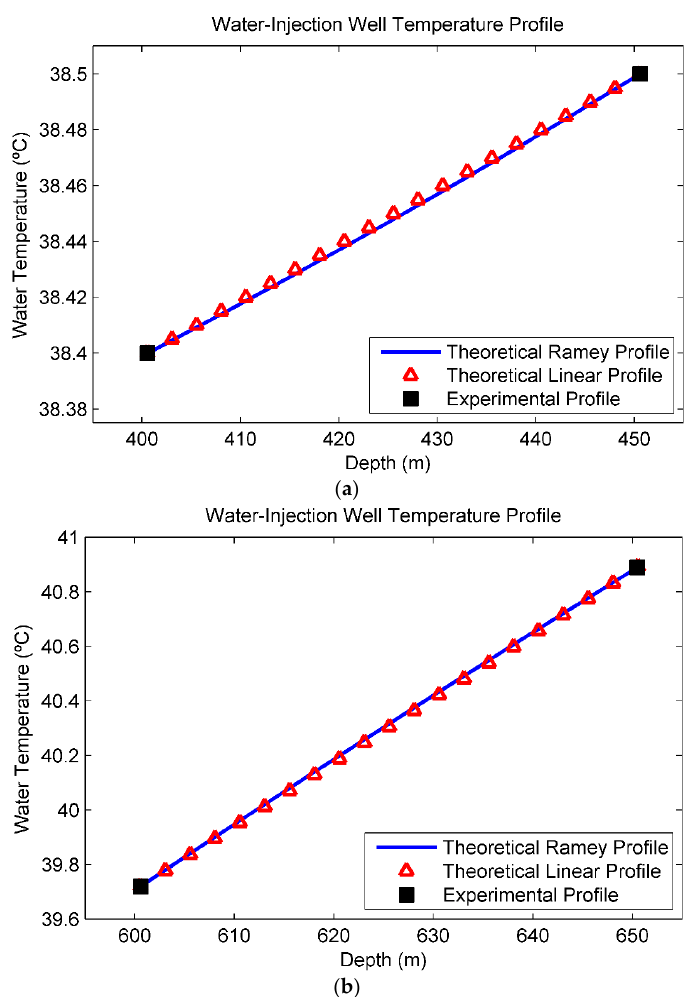
Figure 7. Theoretical (Ramey and Linear) and experimental temperature profiles in the steady-state regions. ( a ) Region upstream from the first injection zone (538 m). The fluid temperature gradient is about 0.002 °C/m; ( b ) Region upstream from the second injection zone (695 m). The fluid temperature gradient is about 0.02 °C/m.